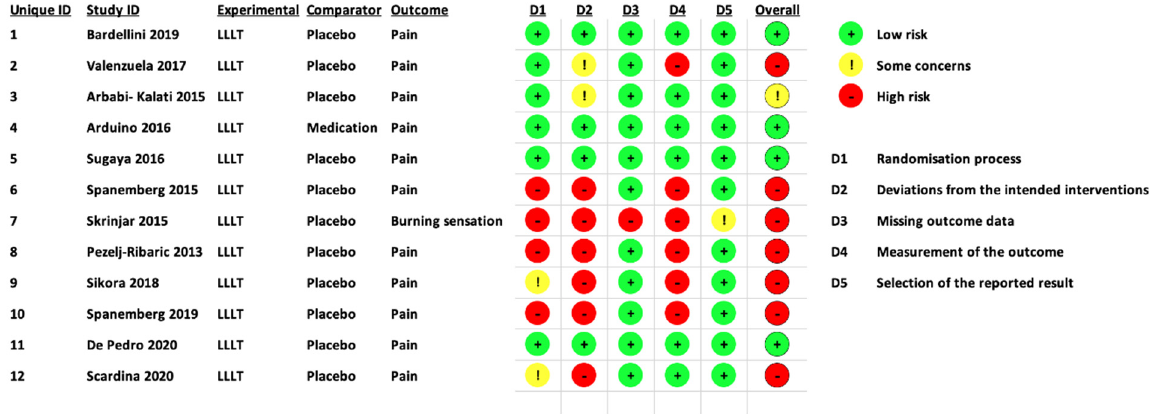
Figure 3. Risk of bias assessment summary of the included studies based on the consensual answers of two individual assessors (R.H. and S.D.).